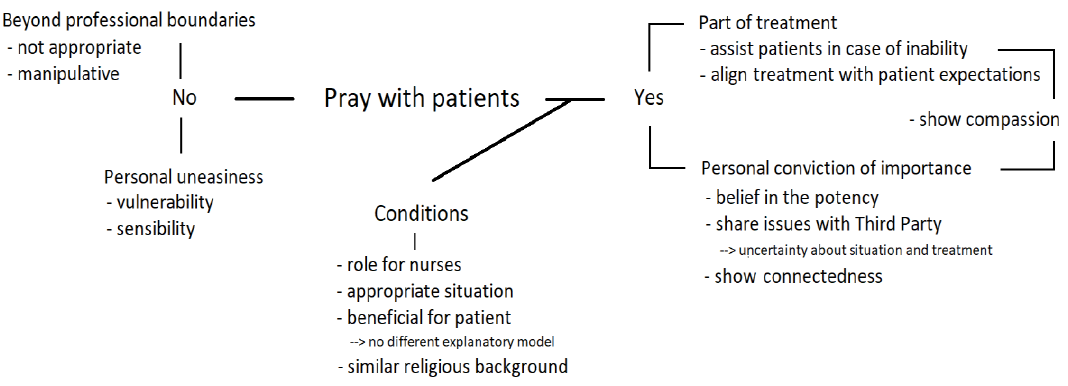
Figure 1. Opinions of mental health professionals.